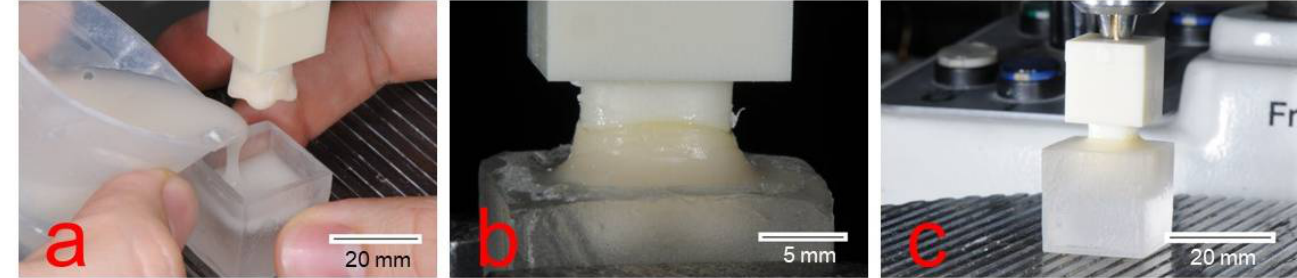
Figure 5. Embedding procedure of the test specimens for the pull-off test ( a – c ).